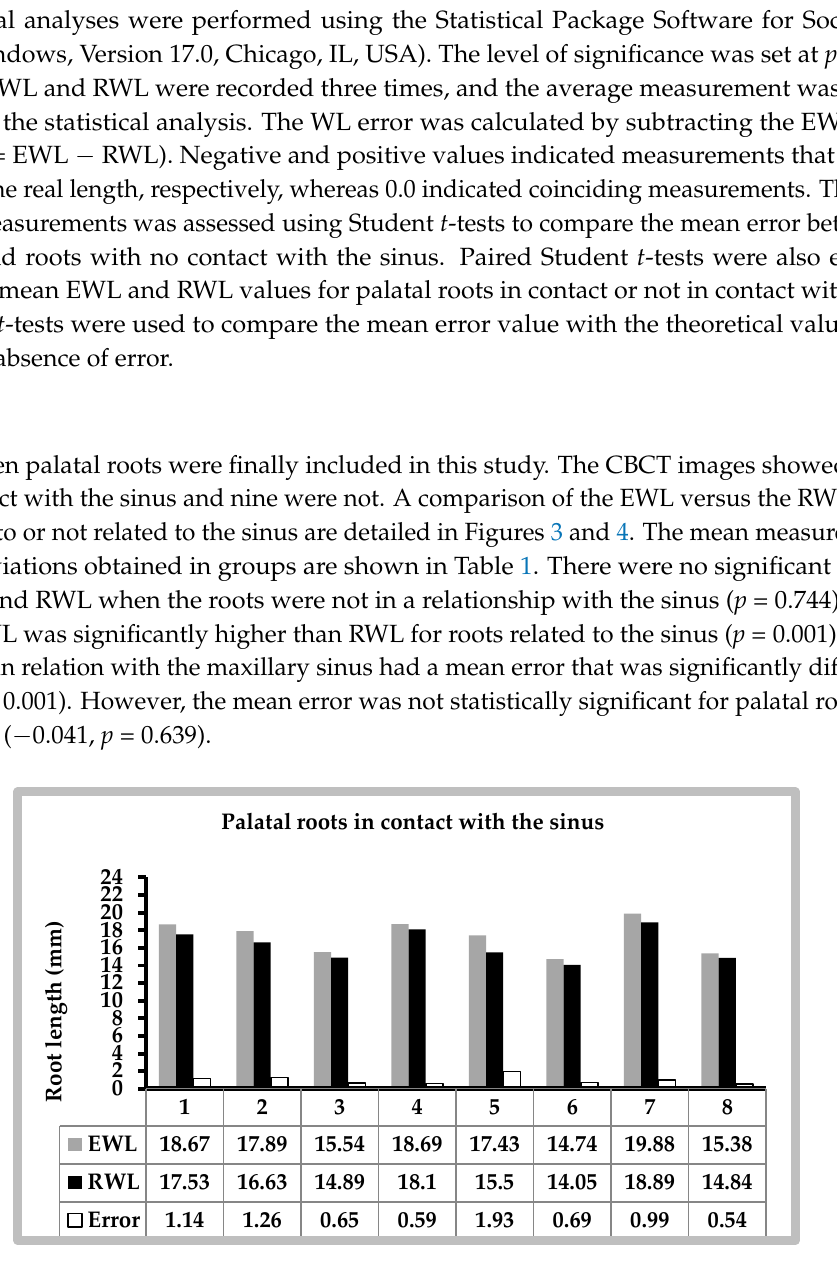
Figure 3. Electronic working length (EWL) versus real working length (RWL) of palatal roots in contact with the sinus.